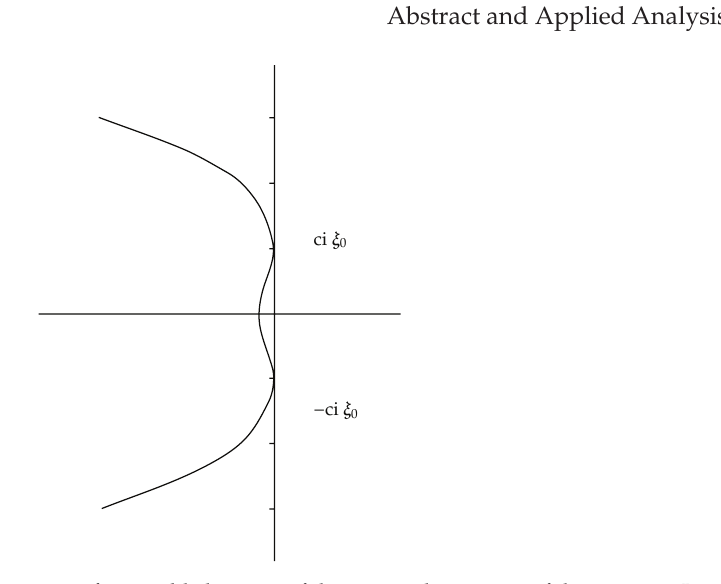
Figure 1: Schematic representation of a possible location of the essential spectrum of the operator L